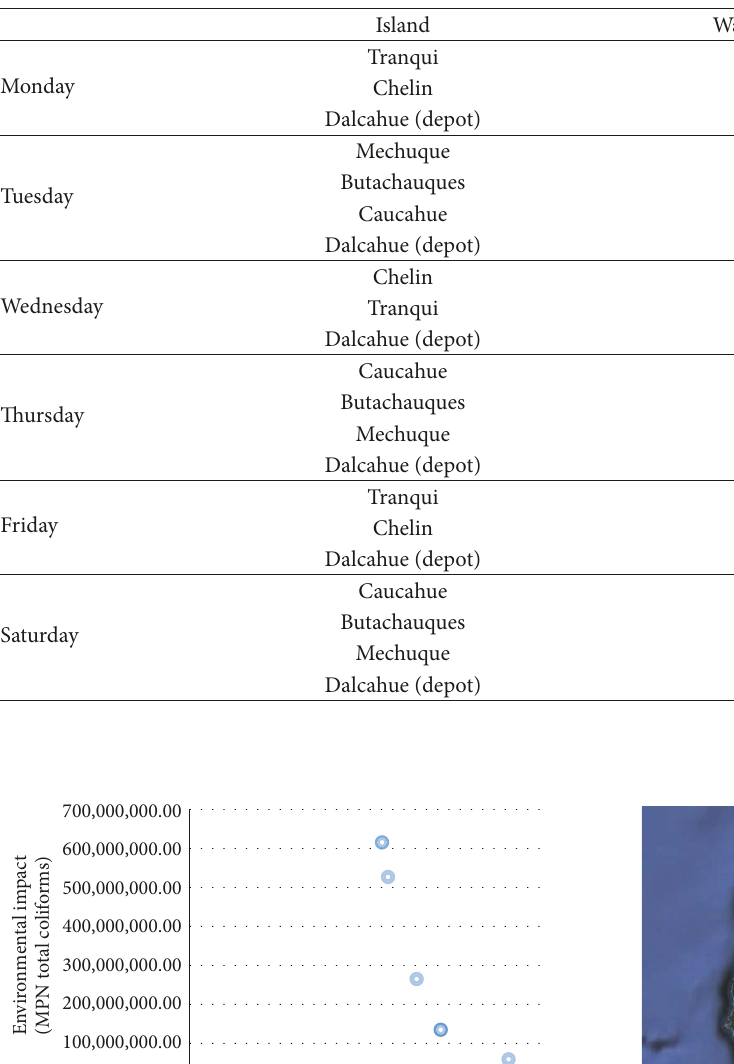
Table 4: Visit sequences and schedules for 𝛼 = 0.2 using the weighted sum method.